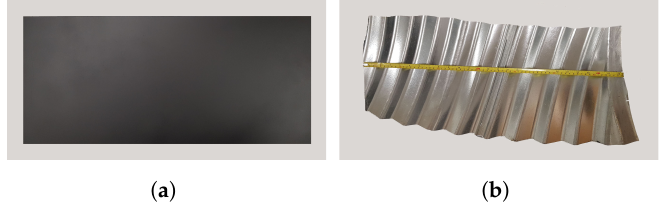
Figure 3. Specimens used in tests. ( a ) Specimen 1. ( b ) Specimen